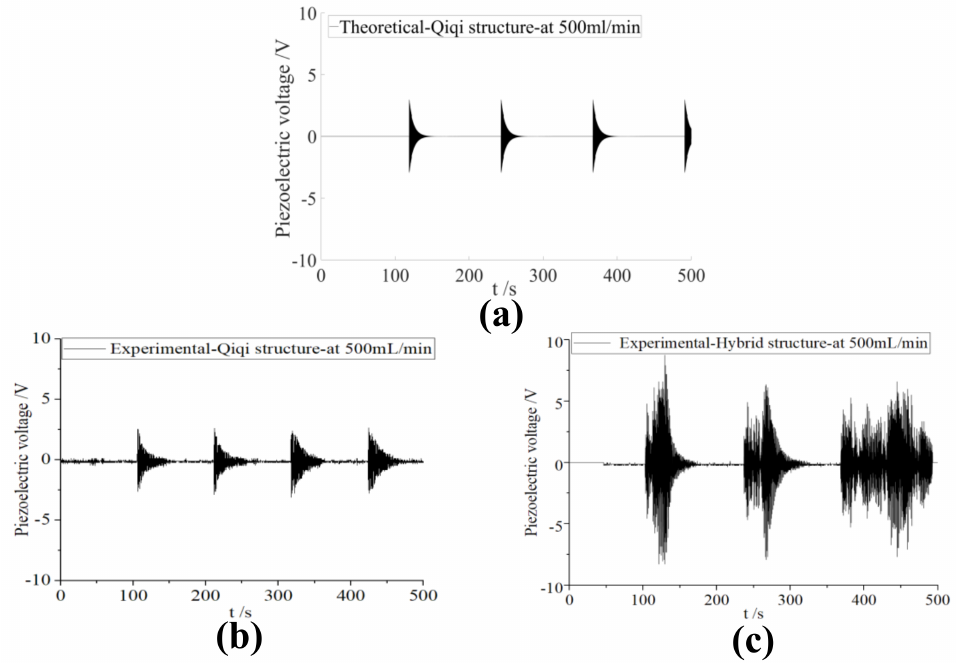
Figure 8. Performance comparison between the Qiqi structure and the proposed hybrid structure: ( a ) theoretical voltage of the Qiqi structure at 500 mL/min; ( b ) experimental voltage of the Qiqi structure at 500 mL/min; ( c ) experimental voltage of the hybrid structure at 500